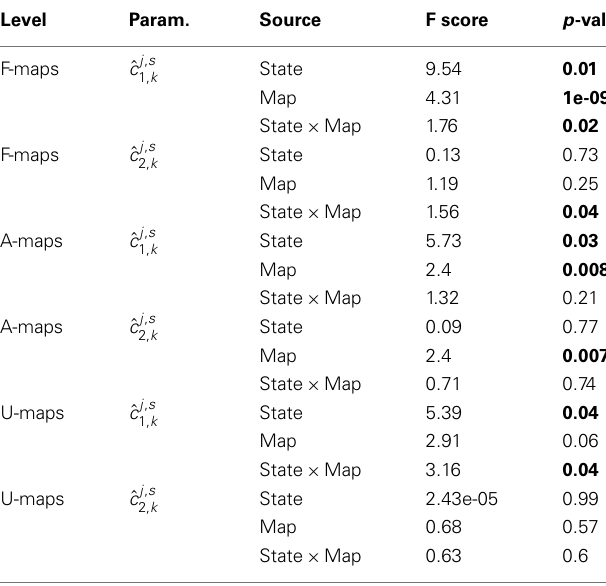
Table 3 | 2-way repeated measuresANOVA results based on the ˆ c j , s i , k